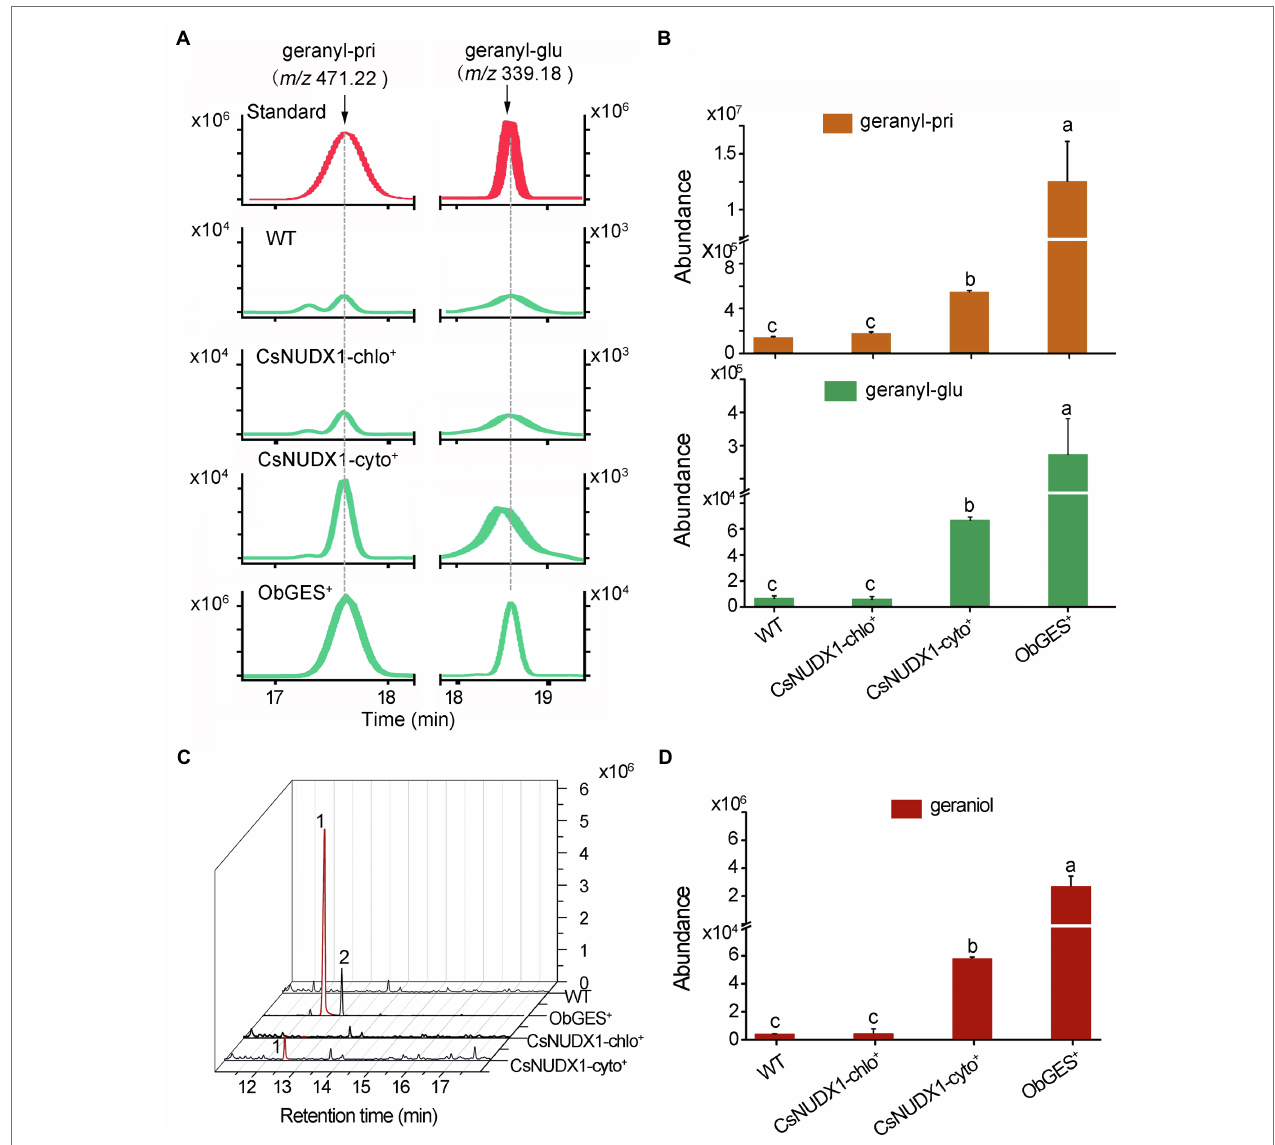
FIGURE 4 | Functional characterization of the two tea CsNUDX1s . (A) Liquid chromatographs of geranyl glucoside, primeveroside found in the transgenic Nicotiana benthamiana leaves transiently overexpressing CsNUDX1-cyto , CsNUDX1-chlo , ObGES respectively, compared to non-transgenic wild-type (WT). The compounds were identified by comparing their corresponding unique ions ( m/z ) and retention times to those of the authentic standards. (B) Quantitative analysis of geranyl glucoside and primeveroside in different transgenic leaves. Columns with the same letters had no significant difference ( p > 0.05). (C) Gas chromatograph of geraniol headspace-SPME collected from different transgenic and non-transgenic leaves after hydrolysis of glycosides with exogenous addition of glucosidase. Peaks 1 and 2, represent geraniol and citral, respectively; Geranyl-pri, geranyl β -primeveroside; geranyl-glu, geranyl β -glucoside; ObGES + , CsNUDX1-cyto + , and CsNUDX1-chlo + , the transgenics overexpressing corresponding genes; WT, non-transgenic wild-type. (D) Quantitative column presentation of geraniol abundances with the data obtained from (C)